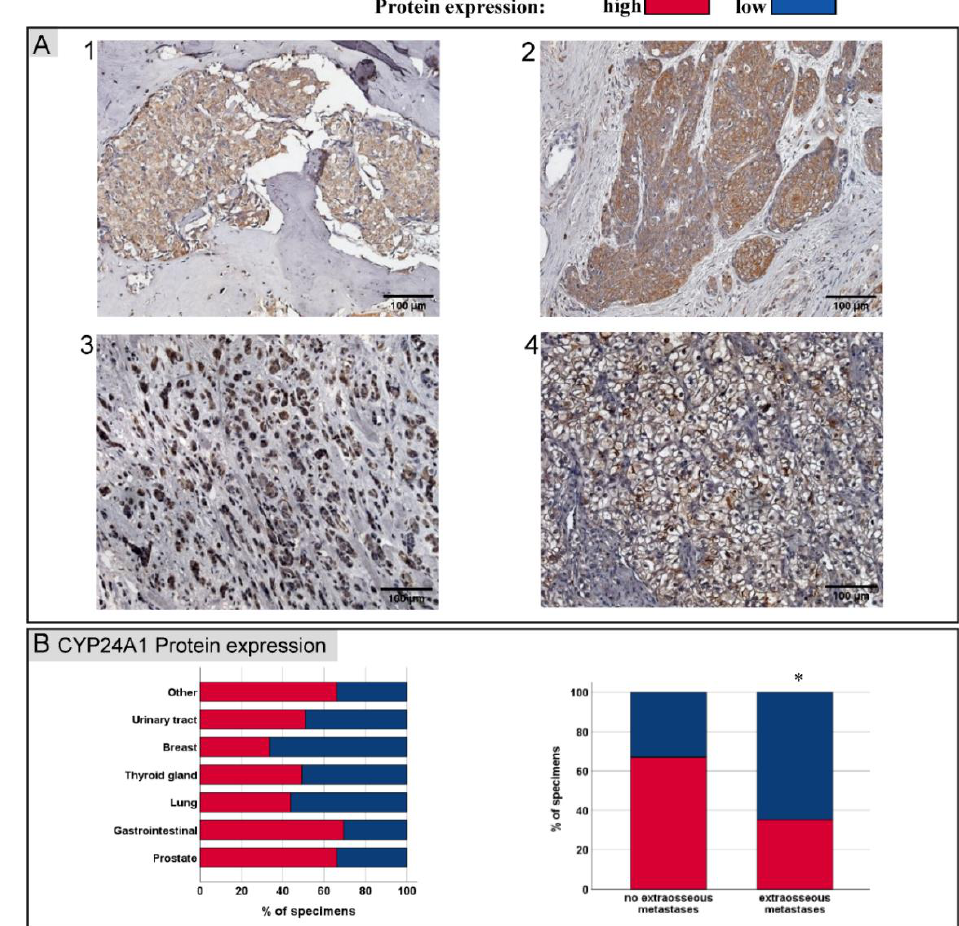
Figure 2 . ( A ) Representative images of IHC staining for CYP24A1 of bone metastases corresponding to Figure 1A IHC images secondary to prostate (1), oesophagus- (2), breast- (3) and renal clear cell cancer (4). ( B ) CYP24A1 protein expression sorted by primary cancers of bone metastases. Similar to nuclear VDR protein expression, patients with further extra-osseous metastases (multiple metastatic cancers) had reduced CYP24A1 protein expression compared to patients without other distant metastases ( p = 0.01); red — high VDR protein expression; blue — low VDR protein expression. Scale bar = 100 µm. * p > 0.05.